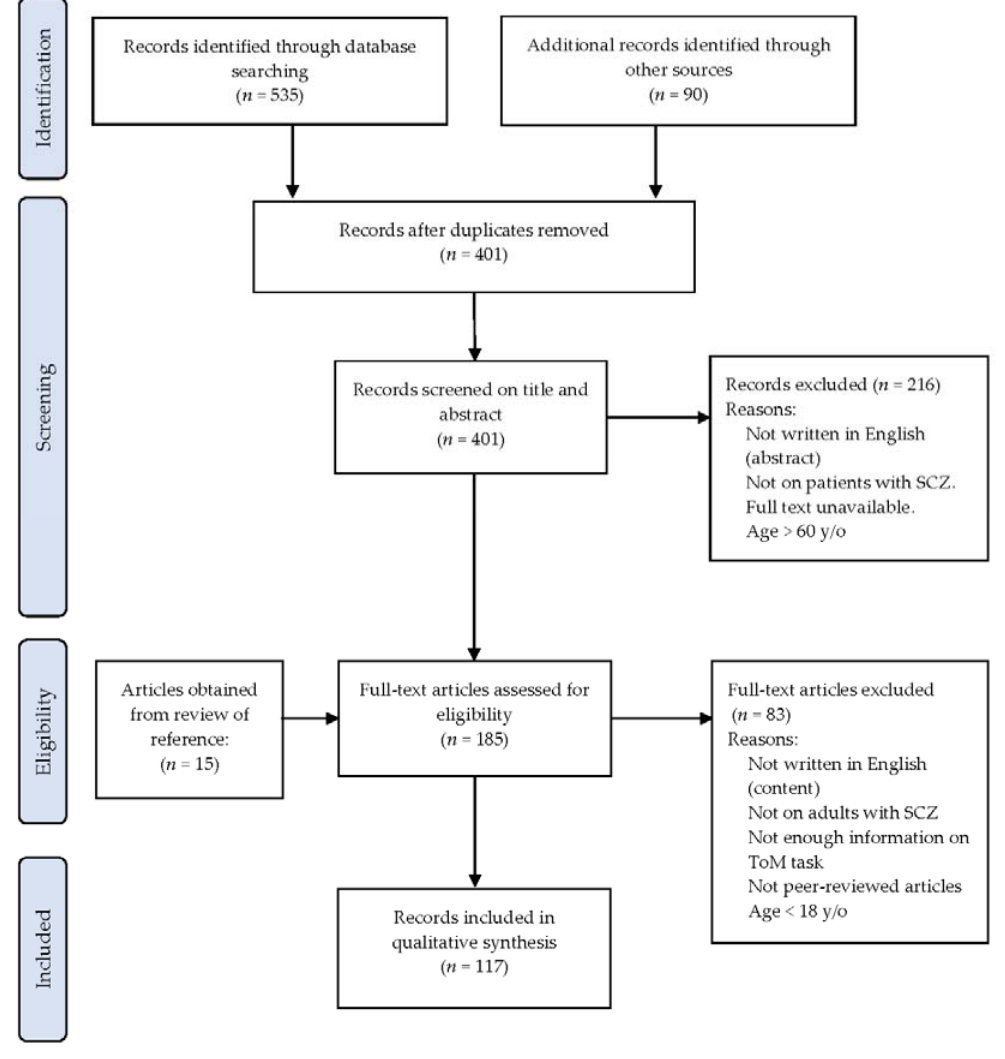
Figure 1. Flow diagram for records included in the systematic review. y/o = years old; SCZ = schizophrenia; ToM = theory of mind.